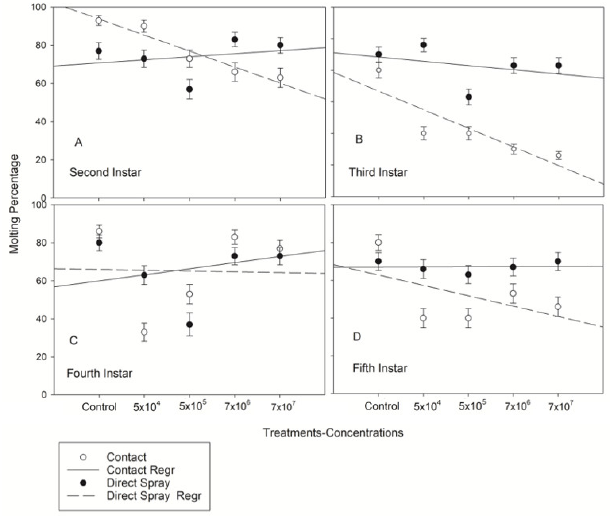
Figure 5. Regression (GLM) (Linear Trend Model) analysis predicting probability of molting percentage of Nezara viridula nymphs ( A – D ) as a function of dose level by contact and direct spray.